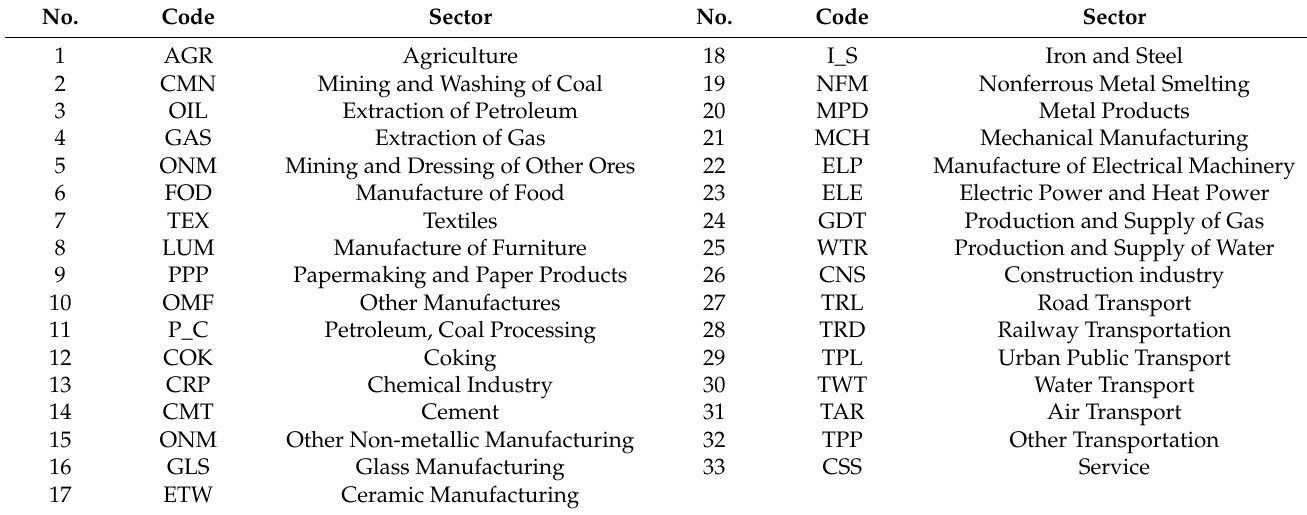
Table A1. Sector definition in the CGE